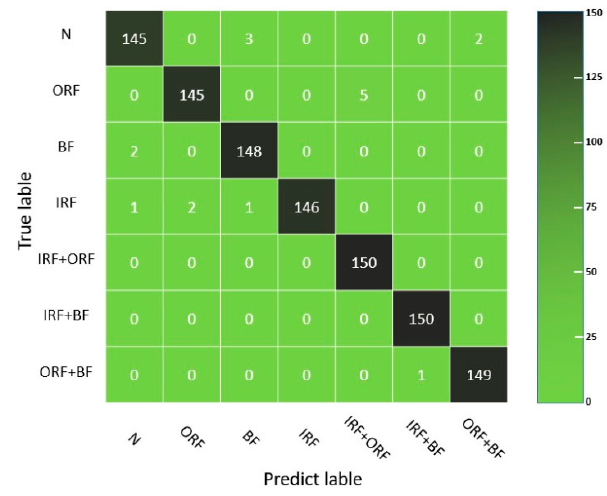
Figure 27. Confusion matrix diagram of the third test result using the proposed method.